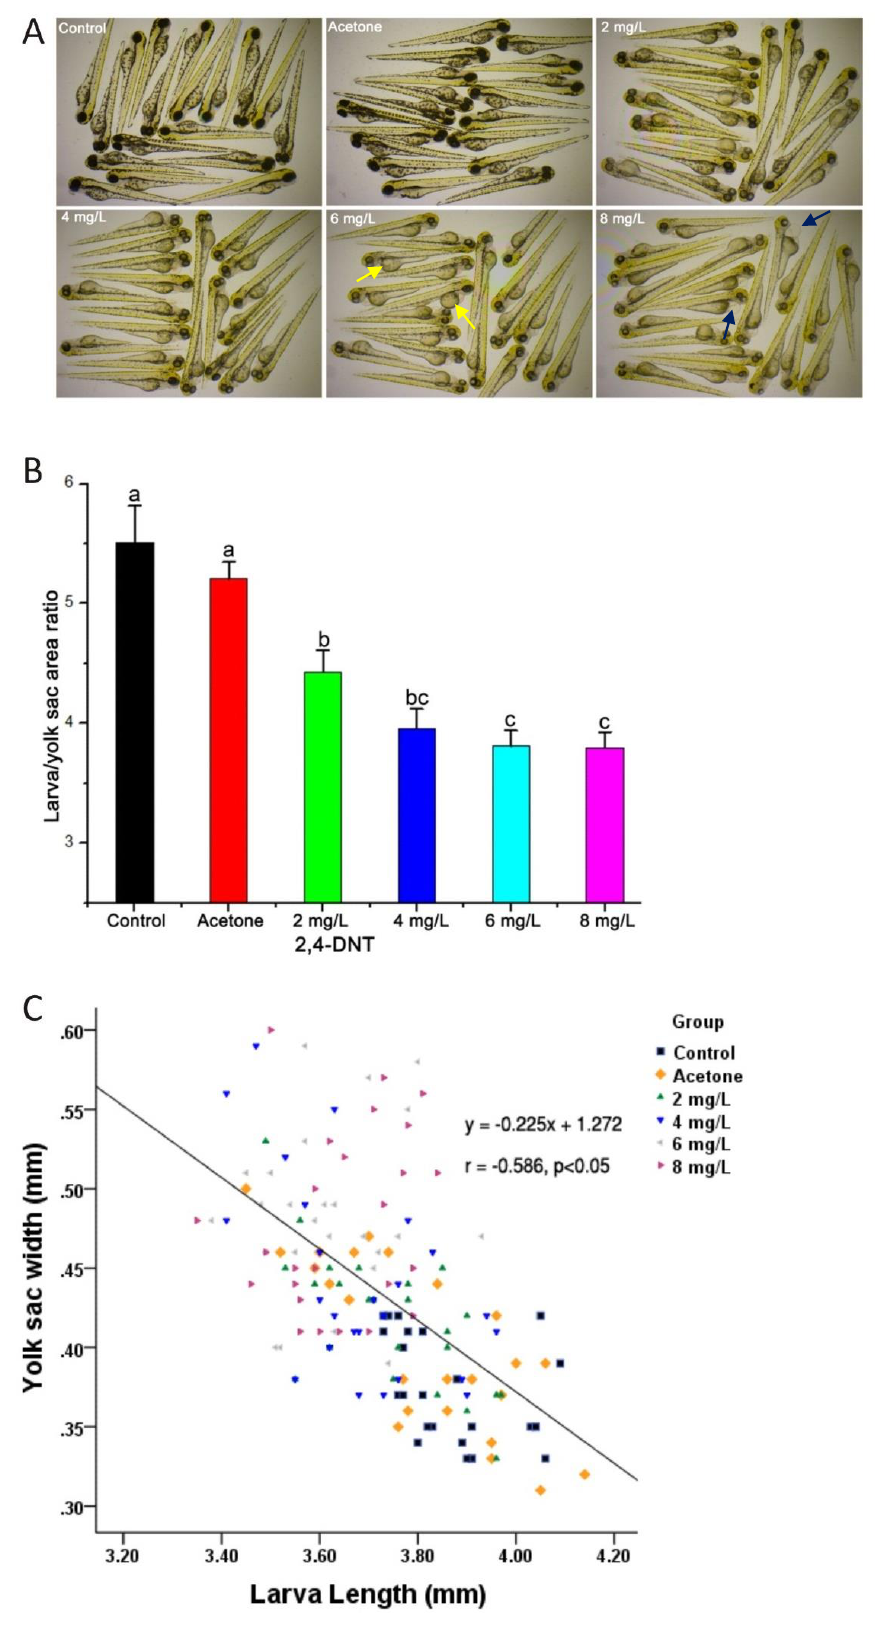
Figure 2. Morphogenesis of zebrafish larvae exposed to di ff erent concentrations of 2,4-Dinitrotoluene (2,4-DNT). A : The morphology of larvae exposed to 2,4-DNT from 2 hpf (hours post-fertilzation)